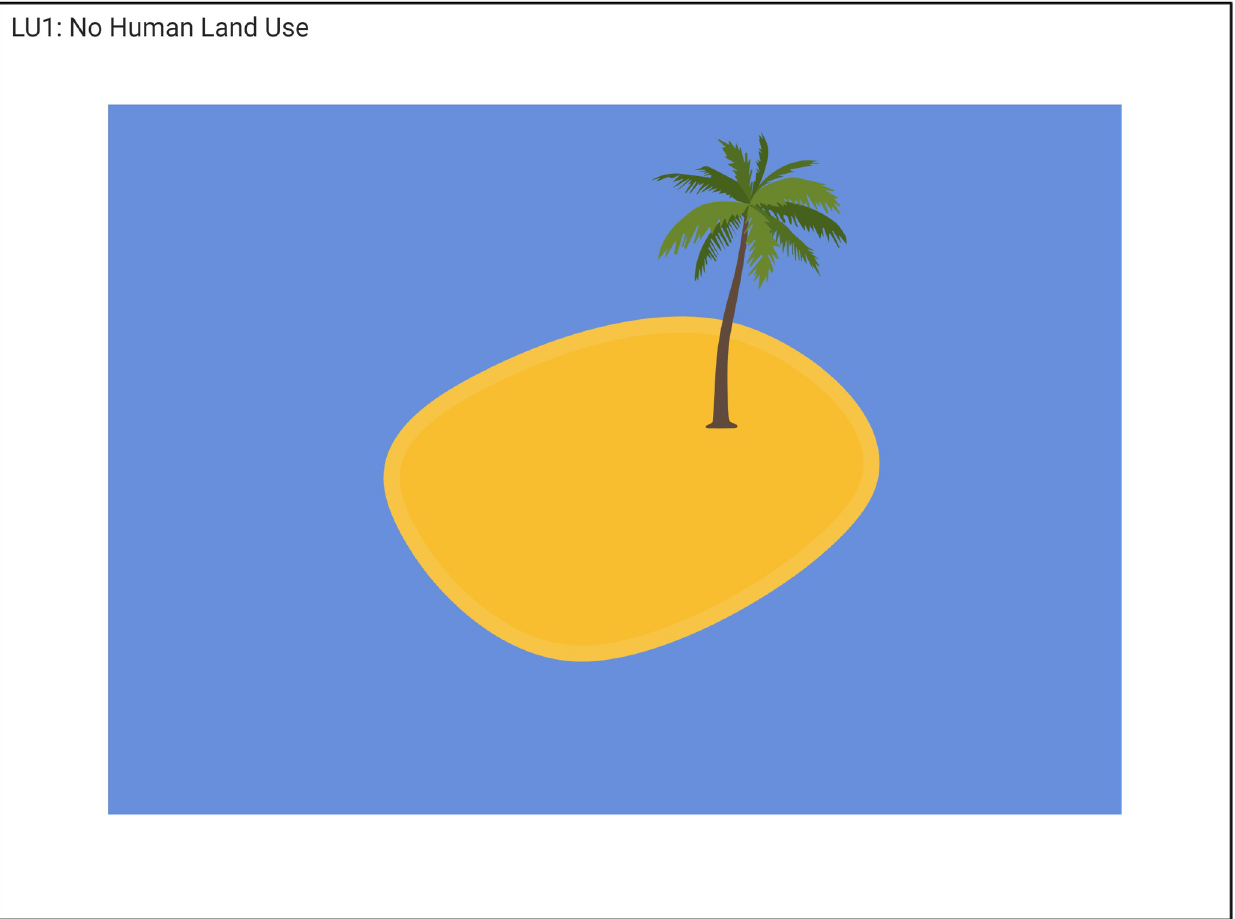
Fig 2. Uninhabited island representing LU1-“no human land use”. Created with BioRender.com, under a CC BY license, with permission from Biorender, original copyright 2020.